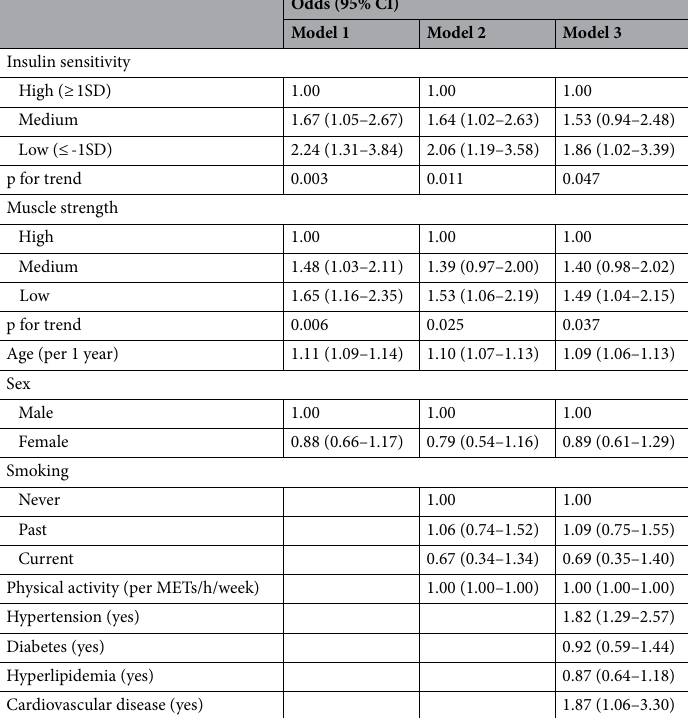
Table 2. Associations between insulin sensitivity and silent lacunar infarcts. Model 1 was adjusted for age and sex. Model 2 was adjusted for muscle strength or insulin sensitivity, smoking, physical activity, and incorporated model 1. Model 3 was adjusted for hypertension, diabetes, dyslipidemia, cardiovascular disease, and incorporated model